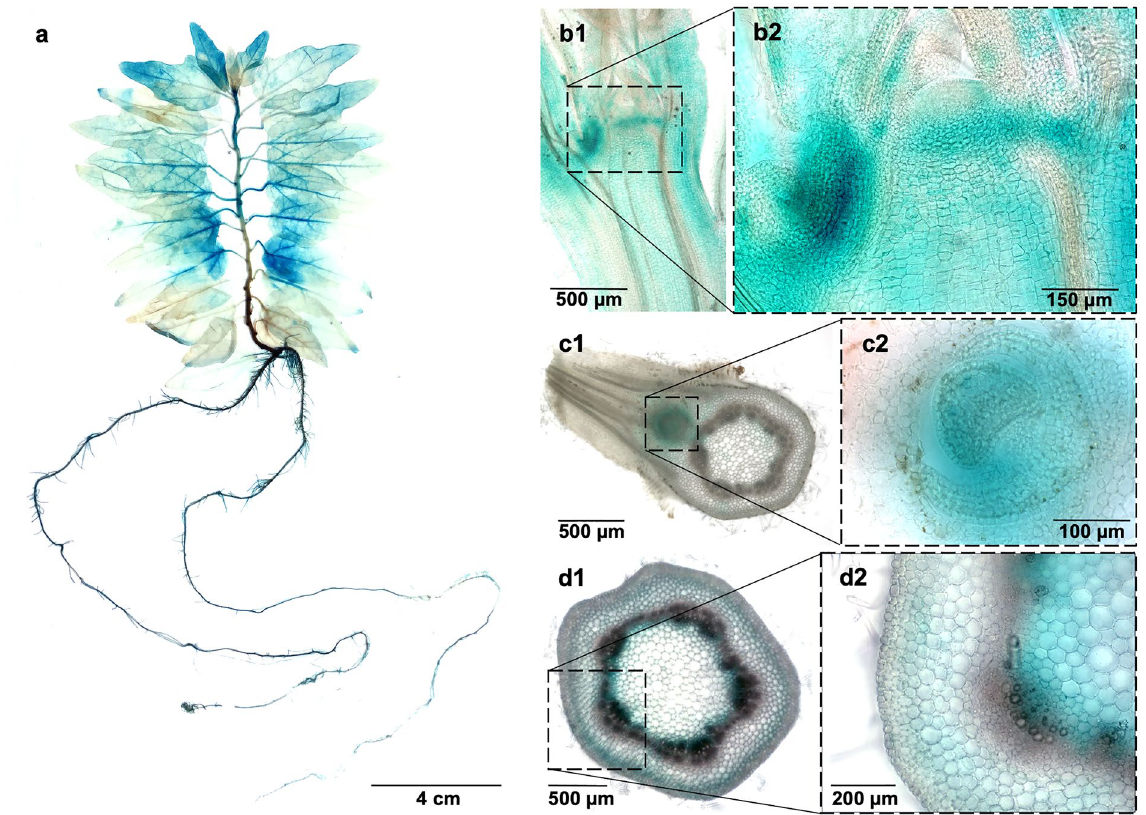
Fig. 1 CWPO-C promoter analyses in poplar using GUS reporter gene. a Whole 6‑week‑old plant. b1 Longitudinal section of shoot tip, b2 Longitudinal section of shoot apex. c1 Cross section of axillary bud, c2 Cross section of axillary meristem. d1 and d2 Cross section of developing xylem in the middle